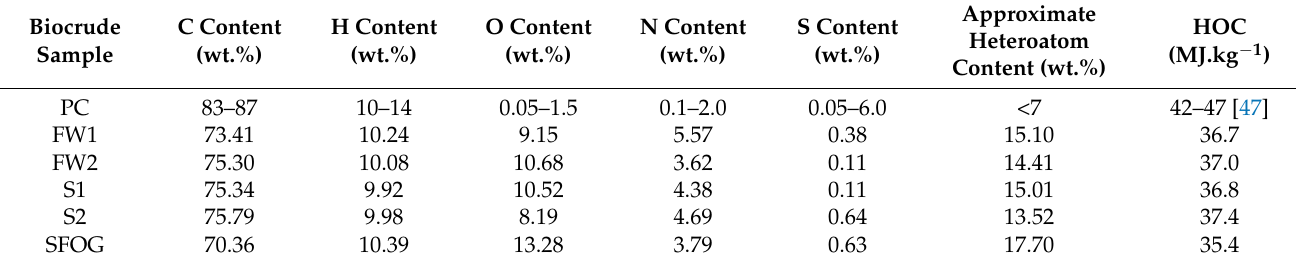
Table 3. Source type and CHONS content of the various wet-waste HTL biocrudes utilized as hydrotreat- ment feeds in this study, as well as the approximate range for traditional petroleum crude